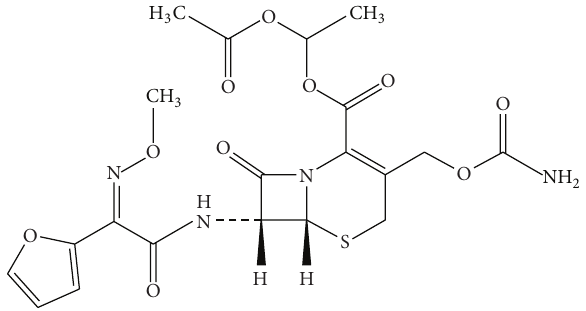
Figure 1: Chemical structure of cefuroxime